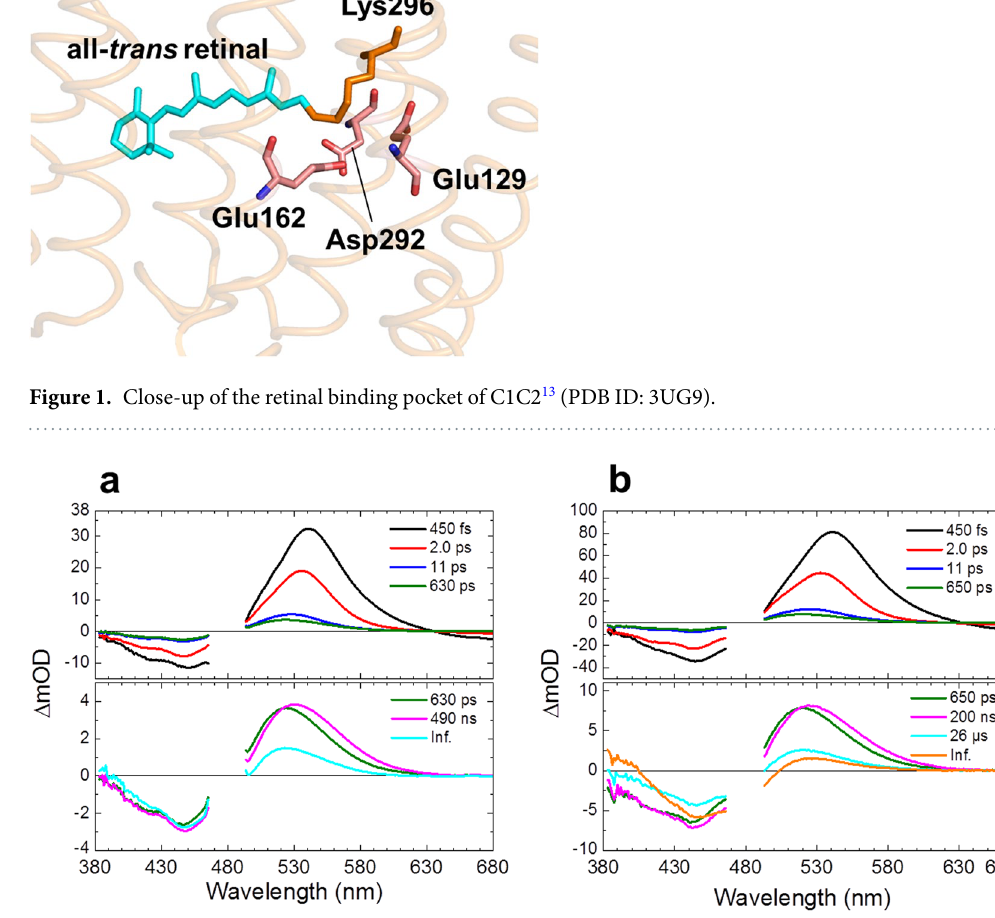
Figure 2. Globally fitted transient absorption spectra of C1C2. EADS of transient absorption data of C1C2 at ( a ) pH 8 and ( b ) pH 10. At pH 8, the spectra were fitted with six components, while seven components were required for pH 10 data. The spectral region of 465–495 nm is omitted because of the strong pump scattering. The 630 ps (at pH 8) and 650 ps (at pH 10) components are shown on both of the top and the bottom panels for